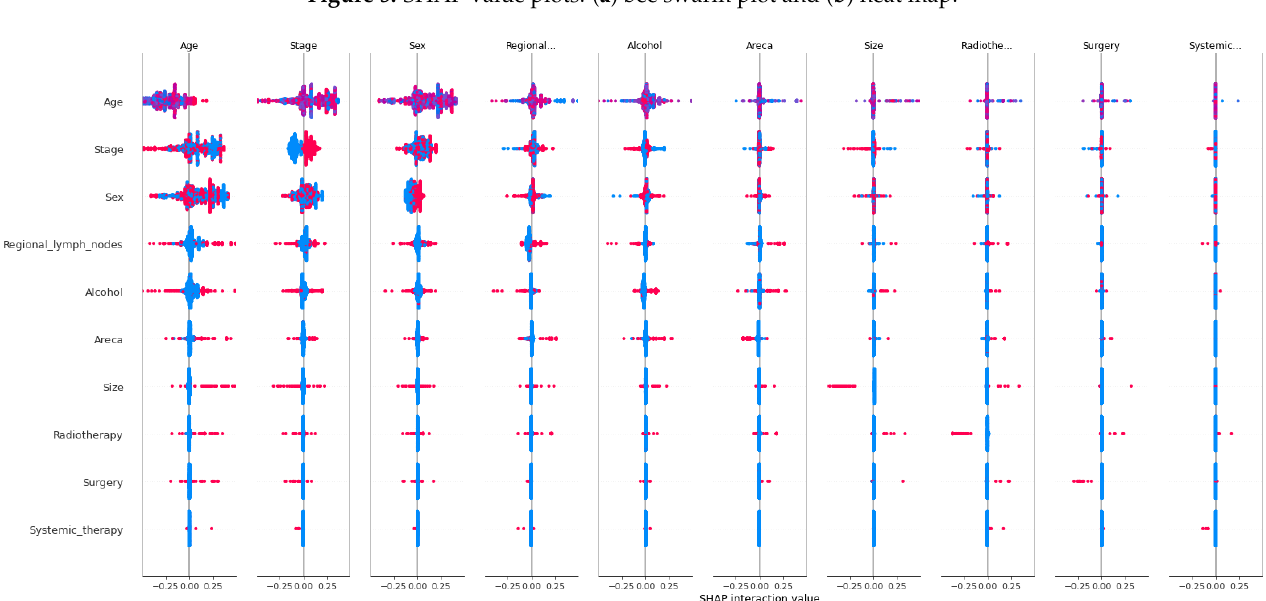
Figure 6. Dependence plot matrix of the SHAP interaction values.